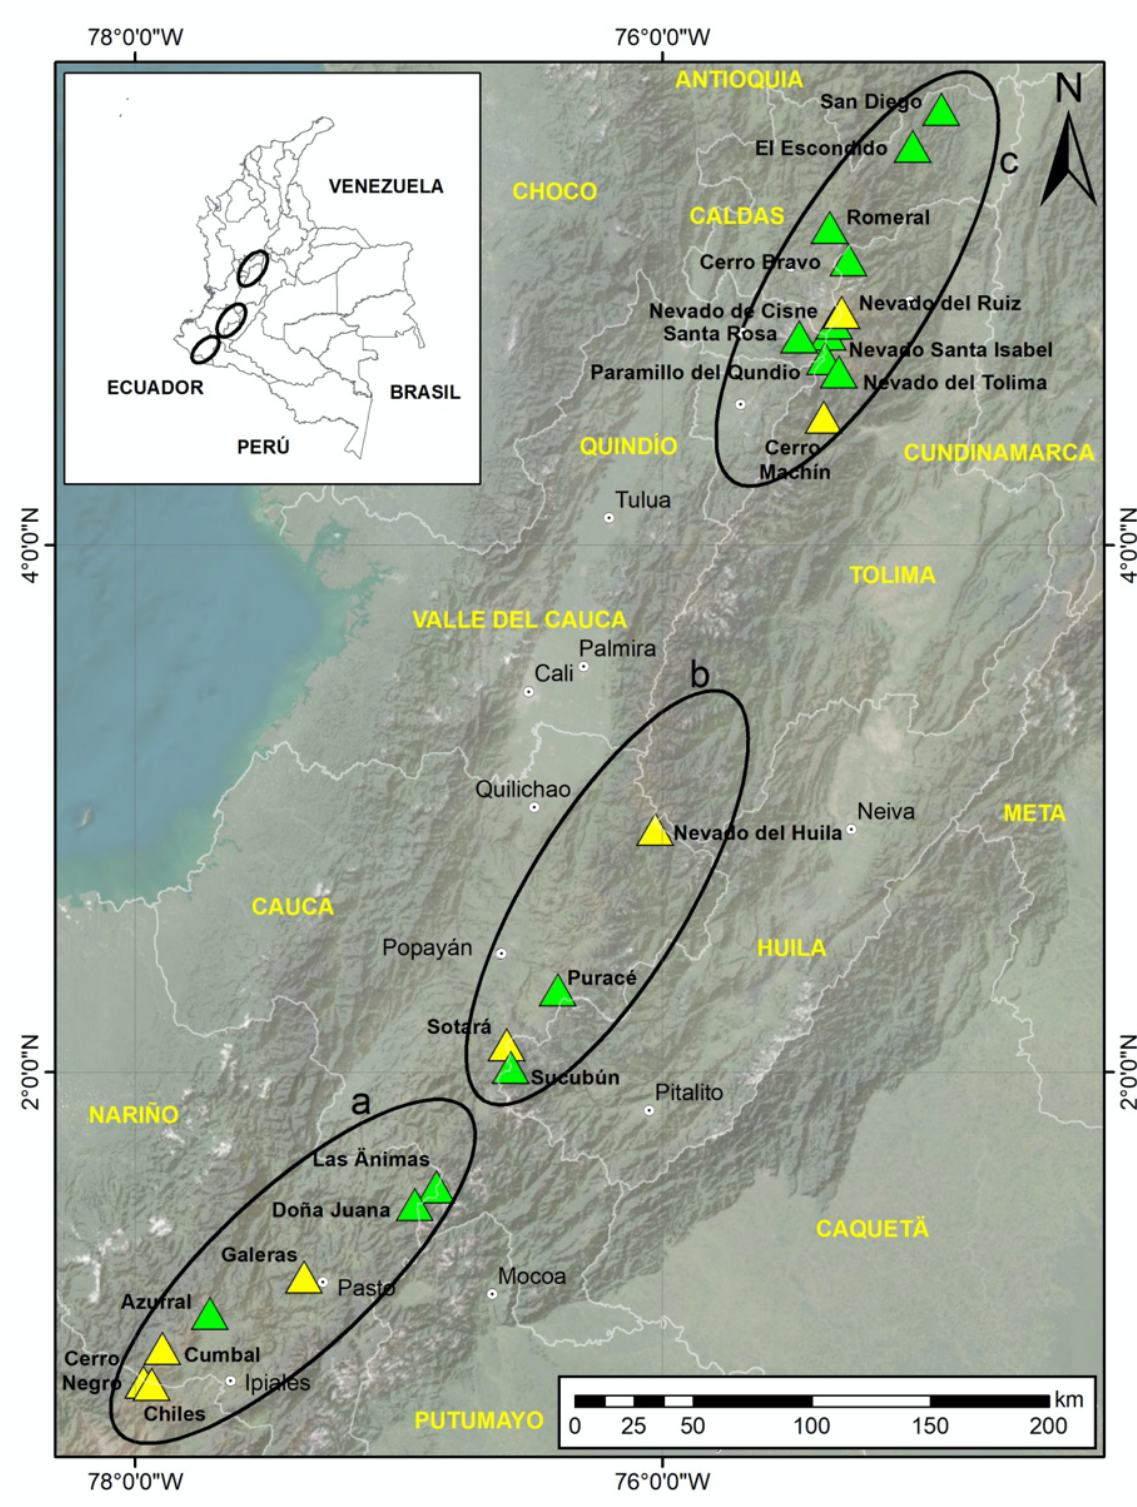
Figure 1: The active volcanoes of the Colombian territory are divided into three geographic segments to the South (a), Center (b), and North (c), and are monitored by the Observatorio Vulcanológio y Sismológico of Pasto (SGC- OVSP), Popayan (SGC-OVSPop), and Manizales (SGC-OVSM), respectively. Color coded triangles give information about the current volcanic activity levels: yellow means activity level III, while, green means activity level IV. The main Provinces are noted in black ellipses and the main cities are also shown with a small white